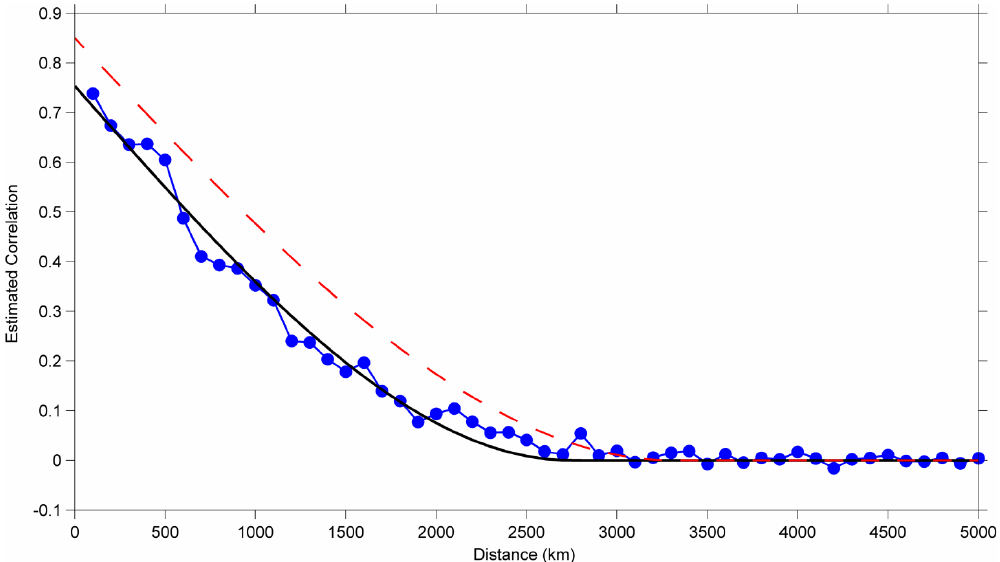
Figure 1. Empirically estimated correlation versus distance for monthly average sea surface temperatures. Correlation was estimated by comparing root-mean-square differences for all possible pairs of HadSST grid cells and all months and binning the population by distance. The black curve reflects a best fit for the spherical correlation function model. The red dashed curve shows the corresponding correlation model derived for land-based measurements (Rohde et al.,